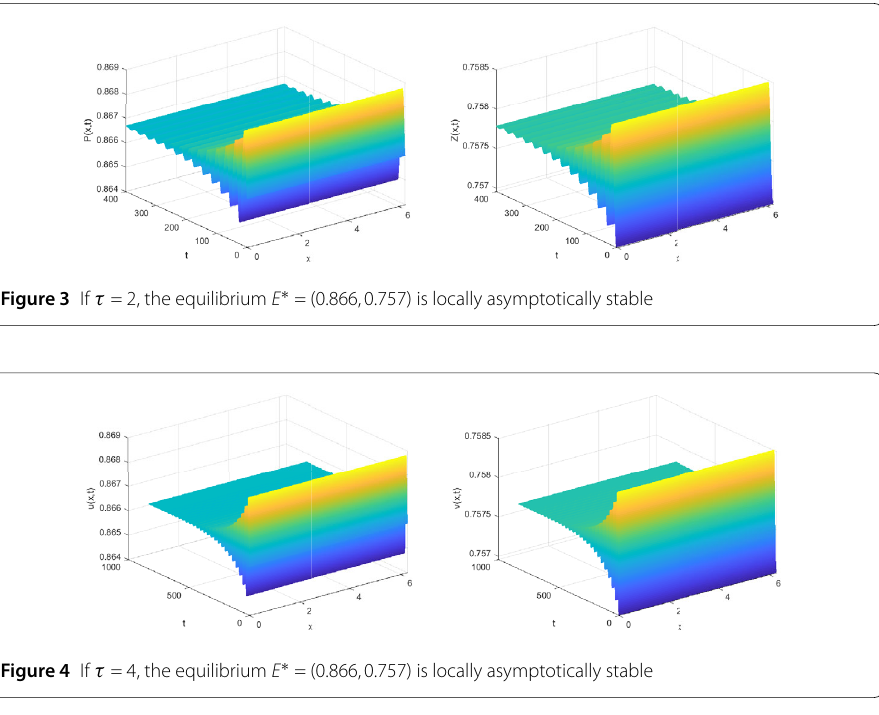
Calculating we get E ∗ = ( P ∗ , Z ∗ ) = (0.866,0.757), τ 0,+